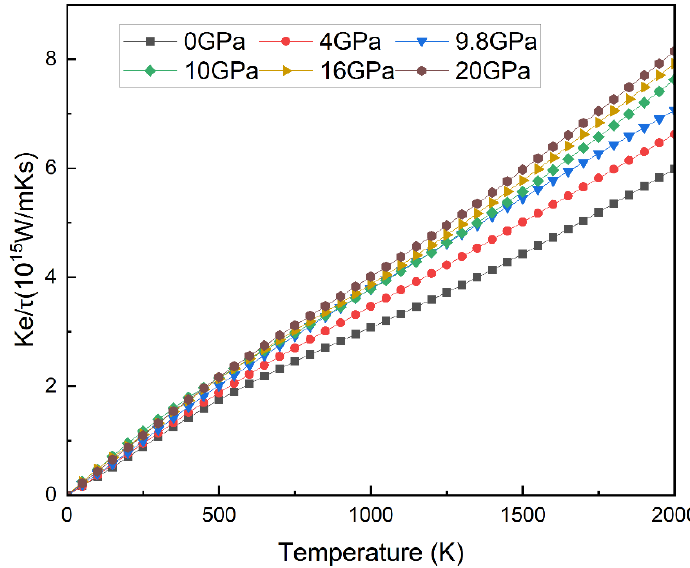
Figure 9. The electronic thermal conductivity of U 3 Si 2 C 2 with dependent relaxation time.